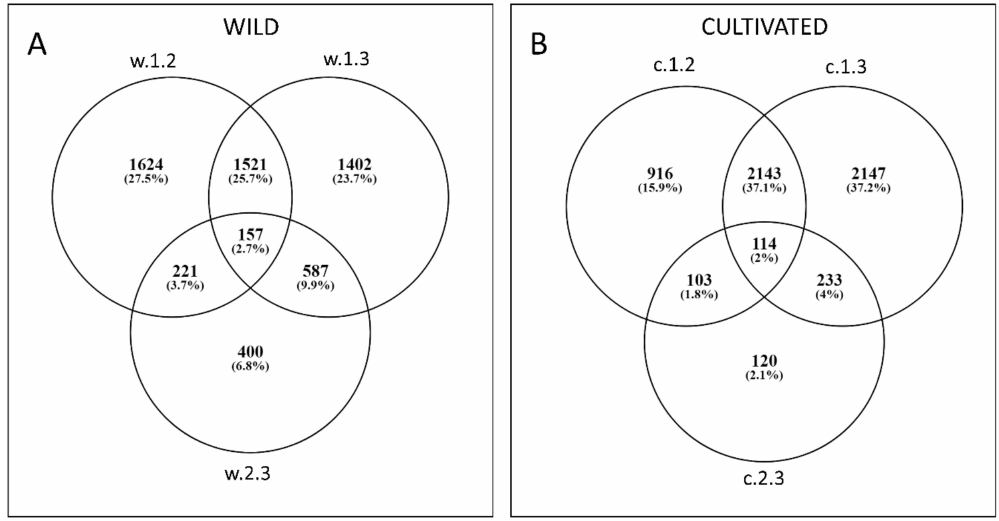
Figure 3. Venn diagrams showing number of DEGs in wild ( A ) and cultivated ( B ) carrots for each comparison (T1 vs. T2, T1 vs. T3, and T2 vs.